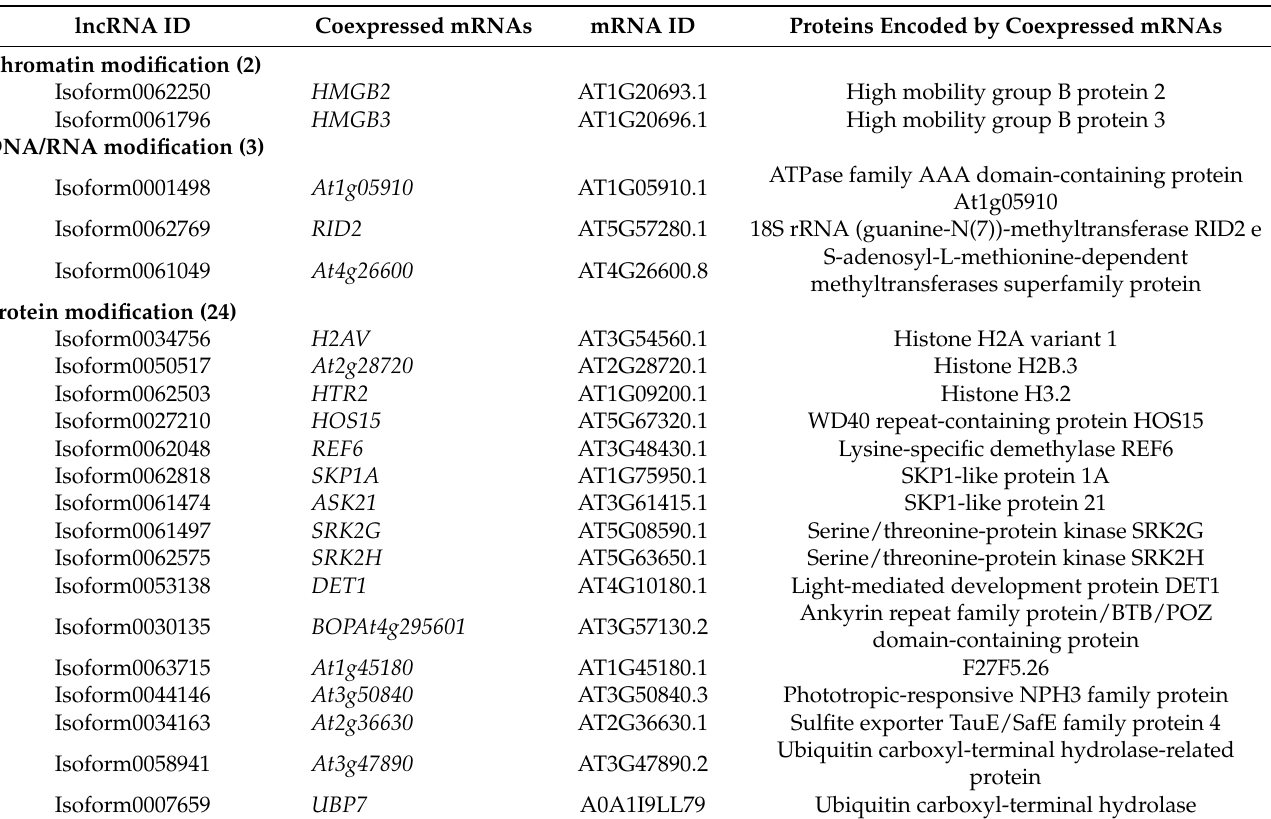
Table 2. Twenty-nine lncRNAs linked with chromatin, DNA/RNA, and protein modification.